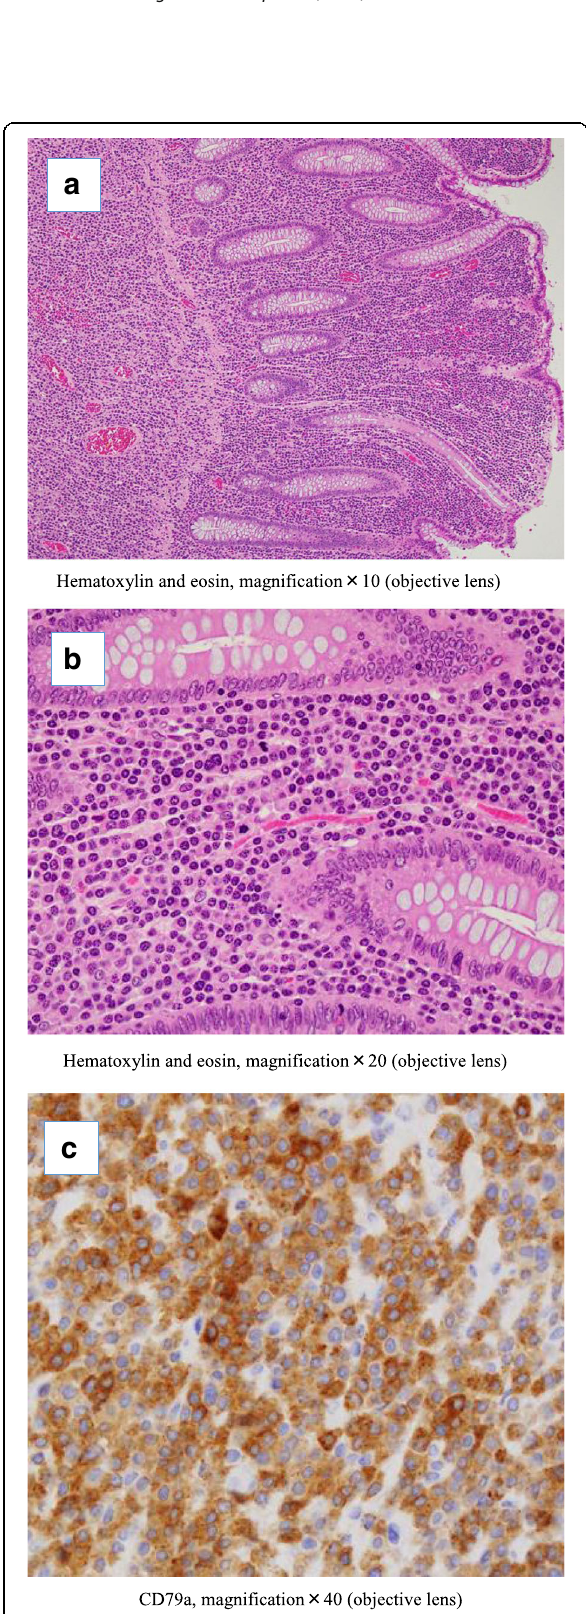
Fig. 3 Microscopic examination. a , b Histopathologic examination of the resected tumor shows diffuse proliferation of atypical plasma cells (hematoxylin and eosin). c Immunohistochemical examination shows CD79a staining